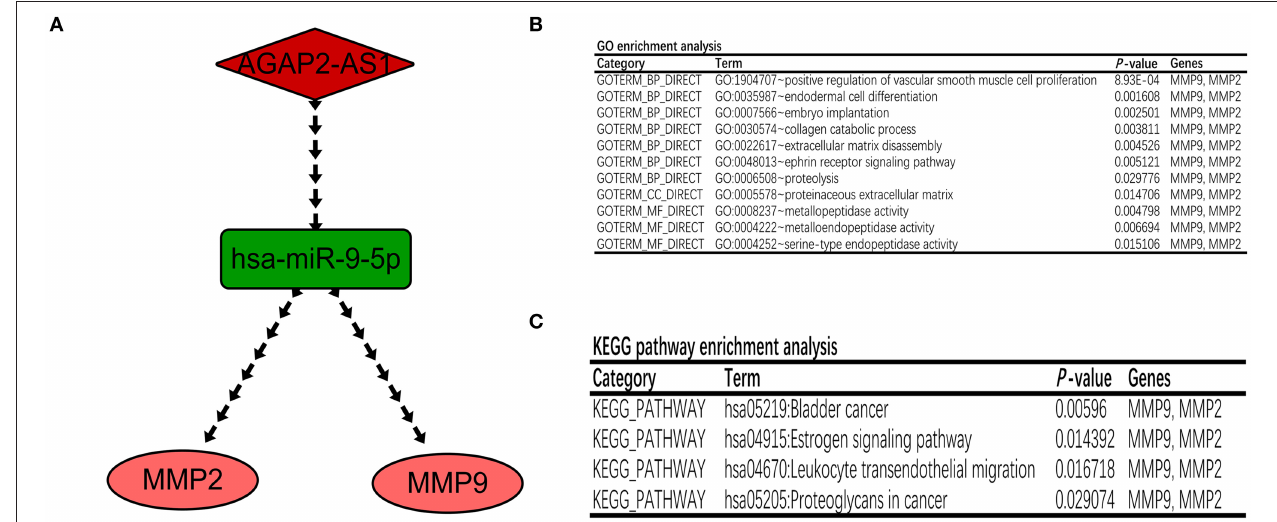
FIGURE 5 | Construction of a GBM-related lncRNA–miRNA–mRNA regulatory network. (A) The ceRNA network associated with GBM prognosis. The red diamond represents the key lncRNA, the green rectangle represents the key miRNA, and the pink ellipse represents the key mRNA. (B,C) GO and KEGG enrichment analyses of genes in the ceRNA regulatory